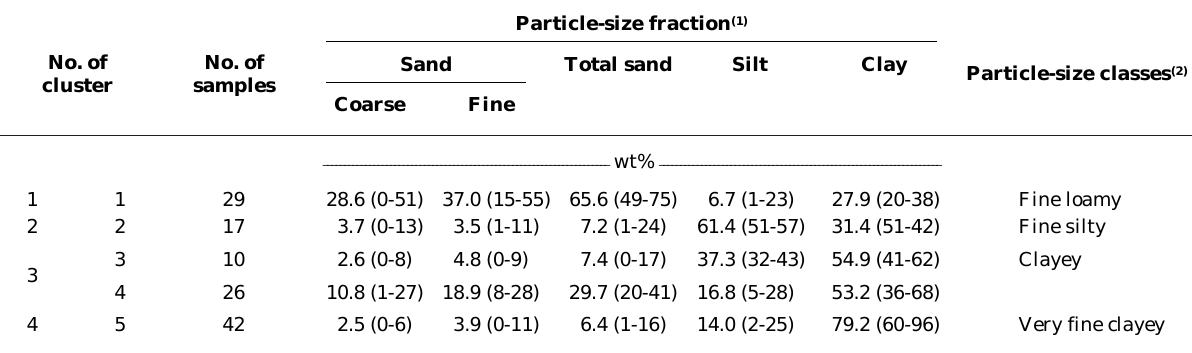
Table 6. Clusters of textural classes obtained by clustering sand, silt and clay fractions of Ferralsols diagnostic B